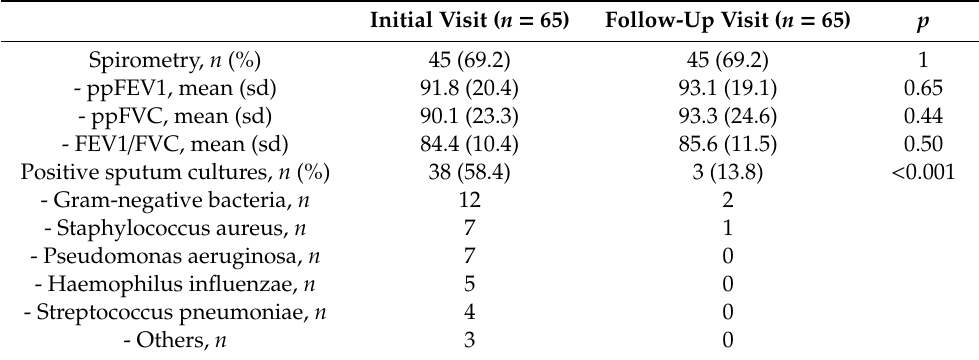
Table 2. Spirometry results and bacteria isolated from sputum cultures at the first and second visit of